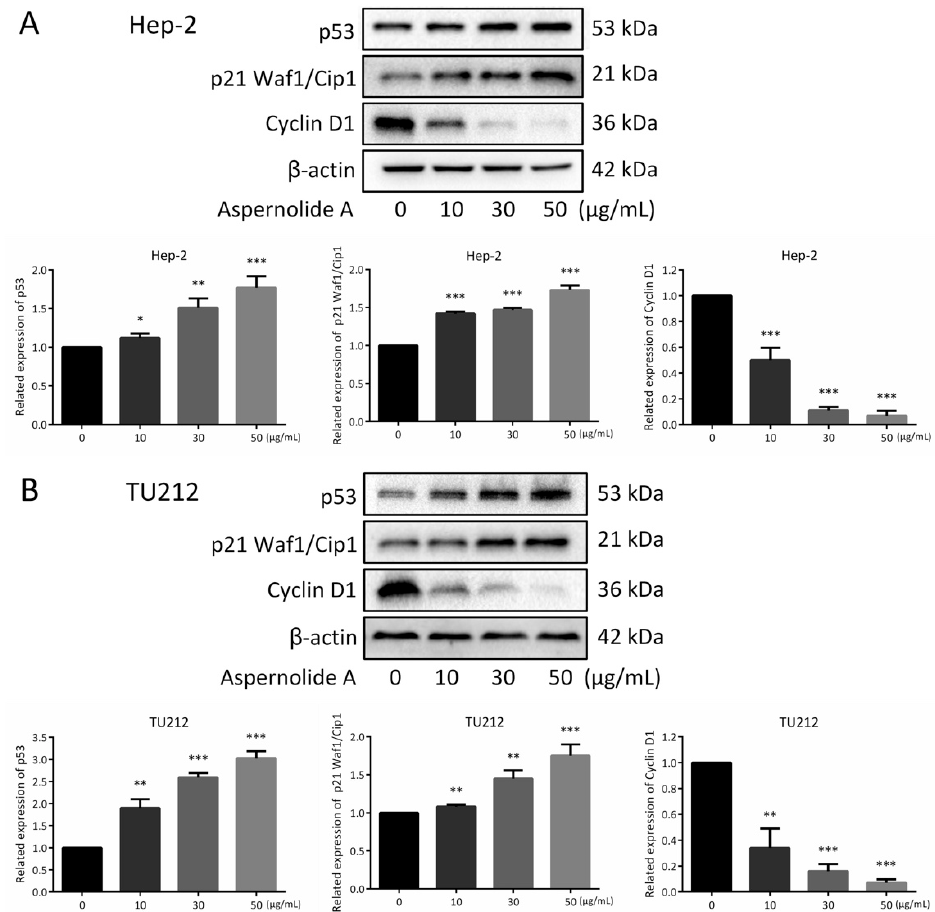
Figure 7. Effects of aspernolide A on the cell cycle related proteins of laryngeal cancer cells. ( A , B ) The related expression of p53, p21 Waf1/Cip1 and Cyclin D1 were detected in Hep-2 and TU212 cells by Western blotting. β -actin was used as a control. (* p < 0.05, ** p < 0.01 or *** p < 0.001).